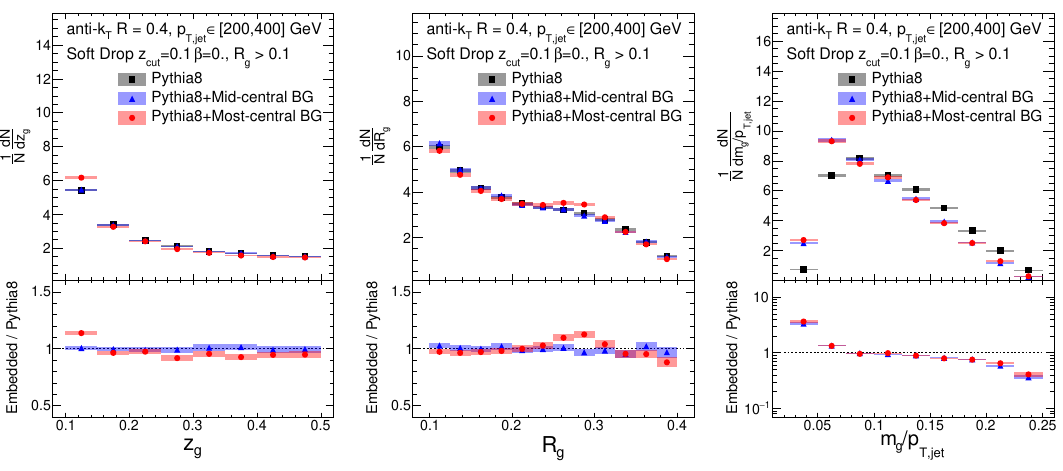
Figure 2 . Distribution of substructure variables of the groomed jets with and without embedding. splittings that satisfy the soft drop